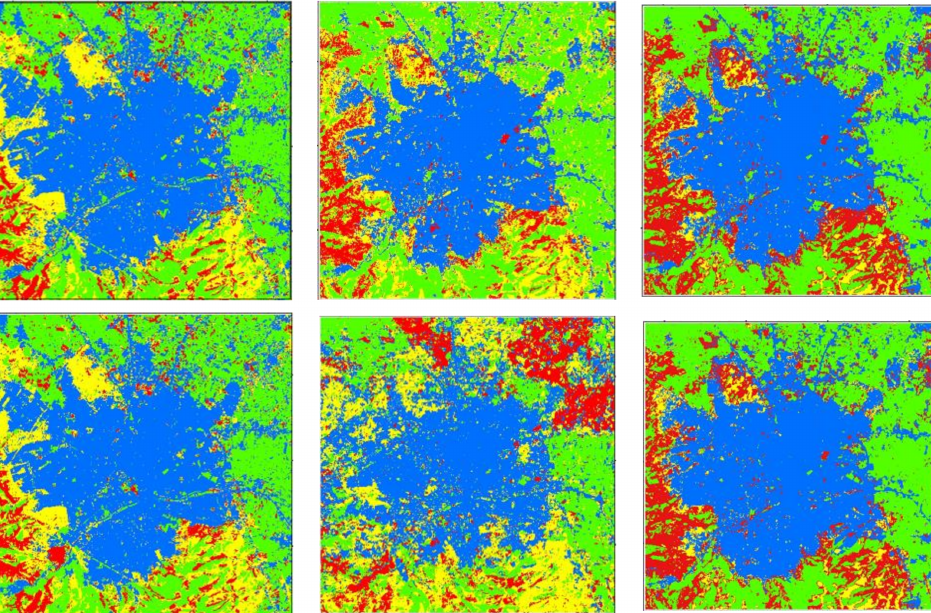
Figure 8. Comparing 2020 land cover prediction maps ( lower maps ) with the 2020 classified maps ( upper maps ) using MLC ( left ), SAM ( middle ), and SVMs ( right ). Blue: Built-up, Red: Rocky, Yellow: Soil, Green: Vegetation.